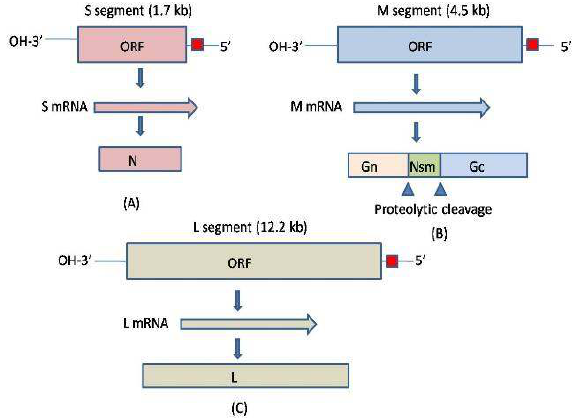
Figure-1. Schematic representation of CCHFV genome. (A). S segment encodes for nucleocapsid, (B). M segment encodes month [29, 30]. The death pattern shows that all the glycoprotein precursor which undergo proteolytic cleavage to form persons died of CCHF were living in close association structural proteins Gc and Gn and non-structural protein Nsm., (C). L Phylogenetic diversity in